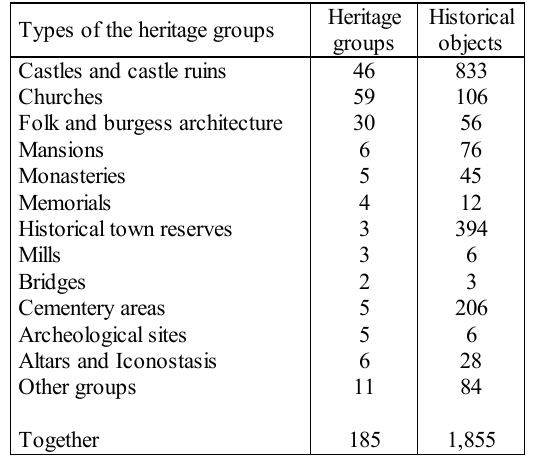
Table 1. Overview of digitalized object